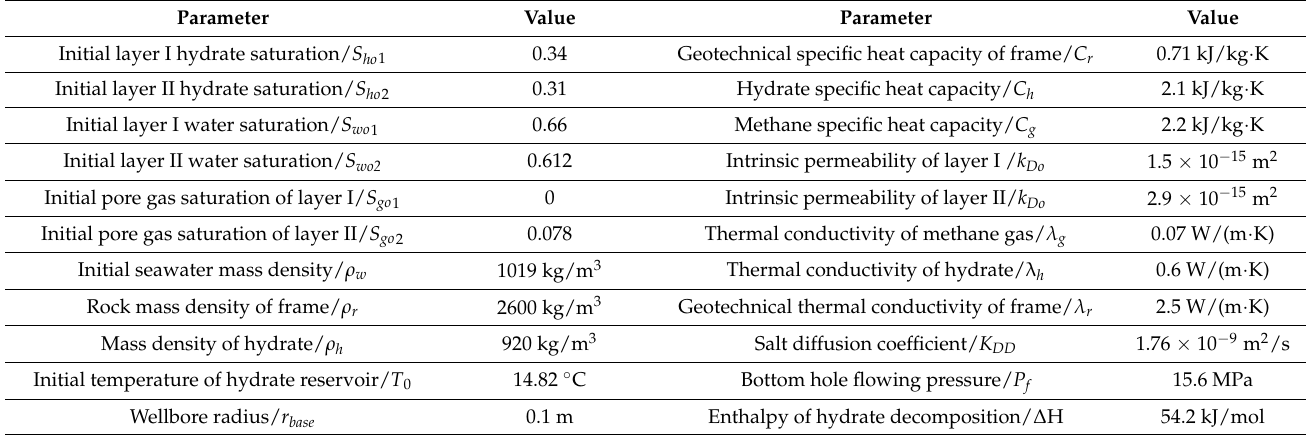
Table 1. Parameters of the methane hydrate reservoir at station W17, South China Sea.